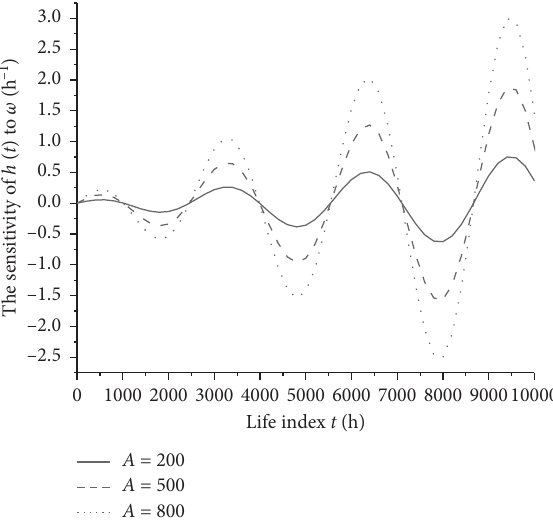
Figure 29: The sensitivity of h ( t ) to 2 ω ( A � 200/500/800).